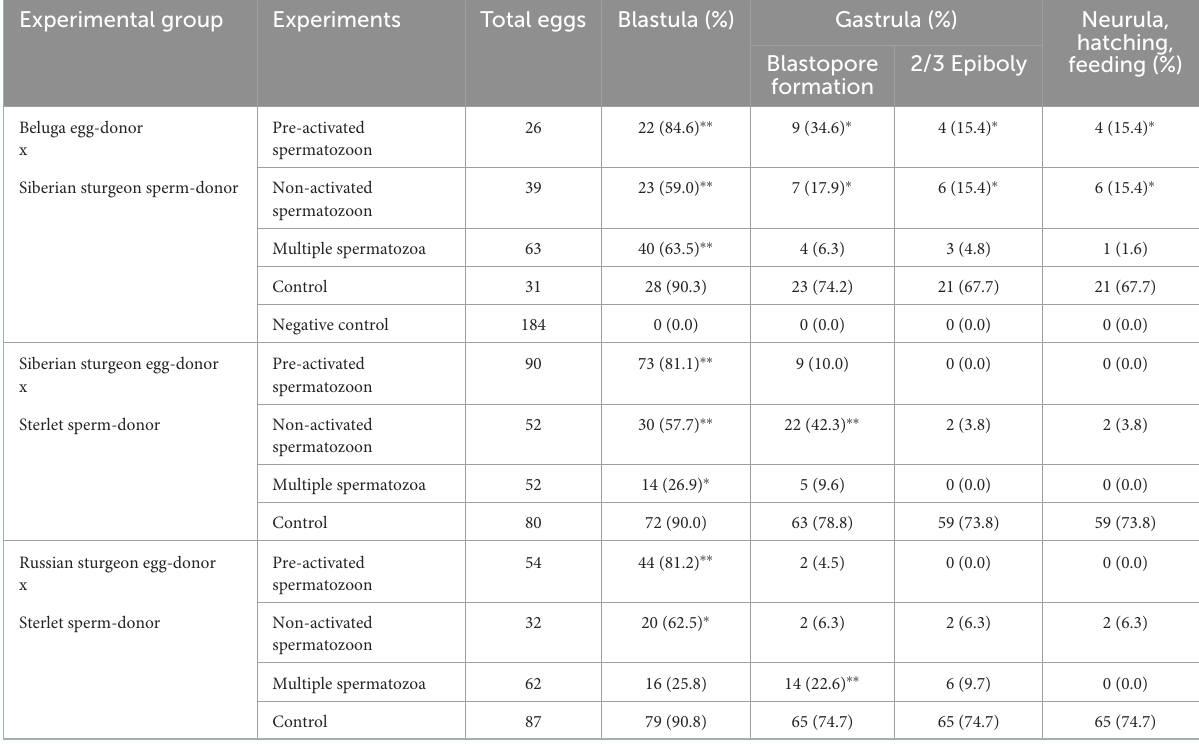
TABLE 1 Developing rates of transplants after the different ICSI experiments using fresh-stripped spermatozoa and non-activated eggs. Experimental